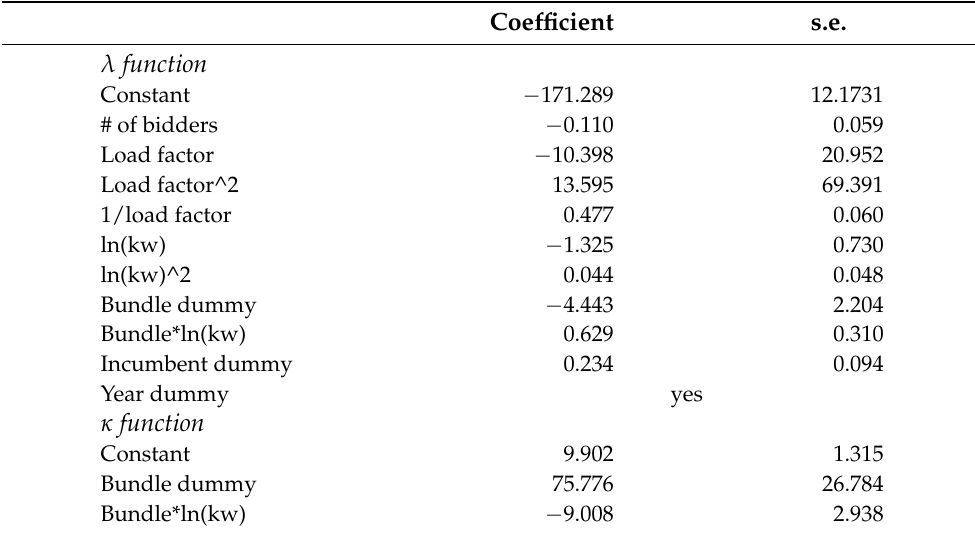
Table 2. Estimation result of bid distribution.